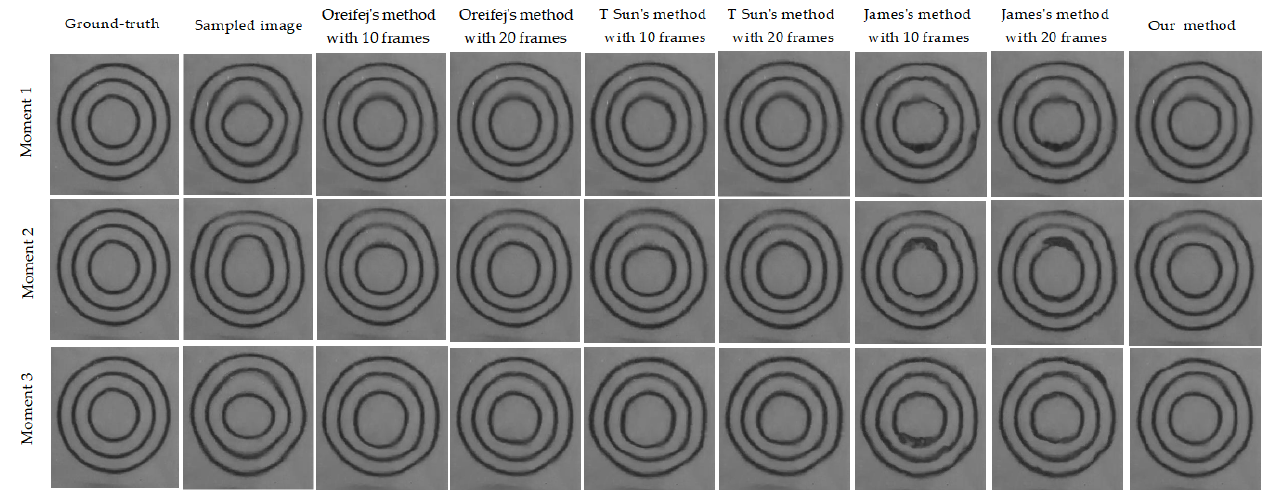
Figure 14. Recovery results of different methods. Left to right: the ground ‐ truth image, the sampled image, the results of Oreifej’s method using 10 frames, the results of Oreifej’s method using 20 frames, the results of T. Sun’s method using 10 frames, the results of T. Sun’s method using 20 frames, the results of James’s method using 10 frames, the results of James’s method using 20 frames, and the results of our method using a single image. Table 2. Numerical comparison based on the real scene datasets [51] (bold values are the best). Methods Sequence Length